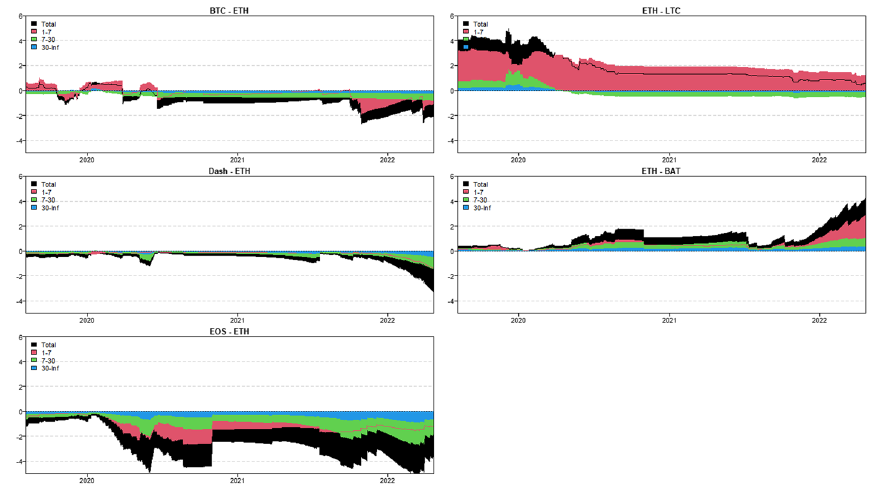
Fig. 31 Dynamic net-pairwise connectedness—realized hyperkurtosis